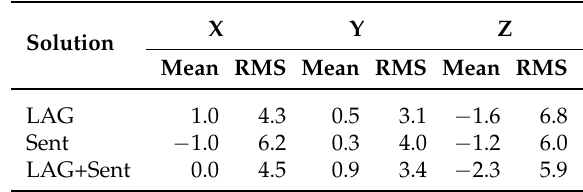
Table 3. Mean offsets and RMS values of the estimated X, Y, Z geocenter coordinates (in mm). The mean values are calculated with respect to the ITRF2014/SLRF2014.